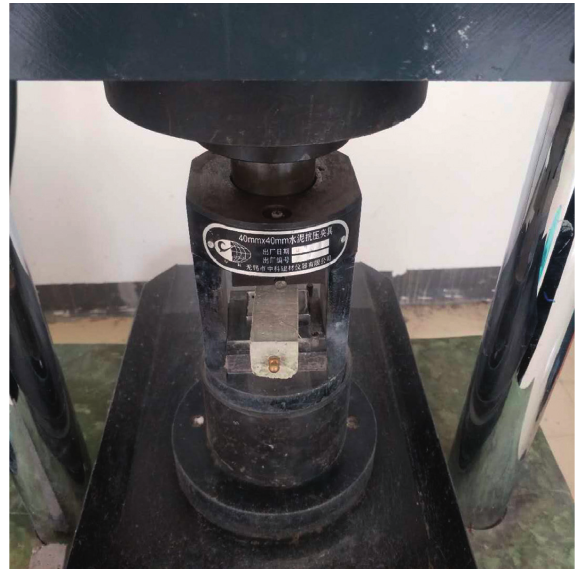
Figure 4: Fixture for testing compressive strength.